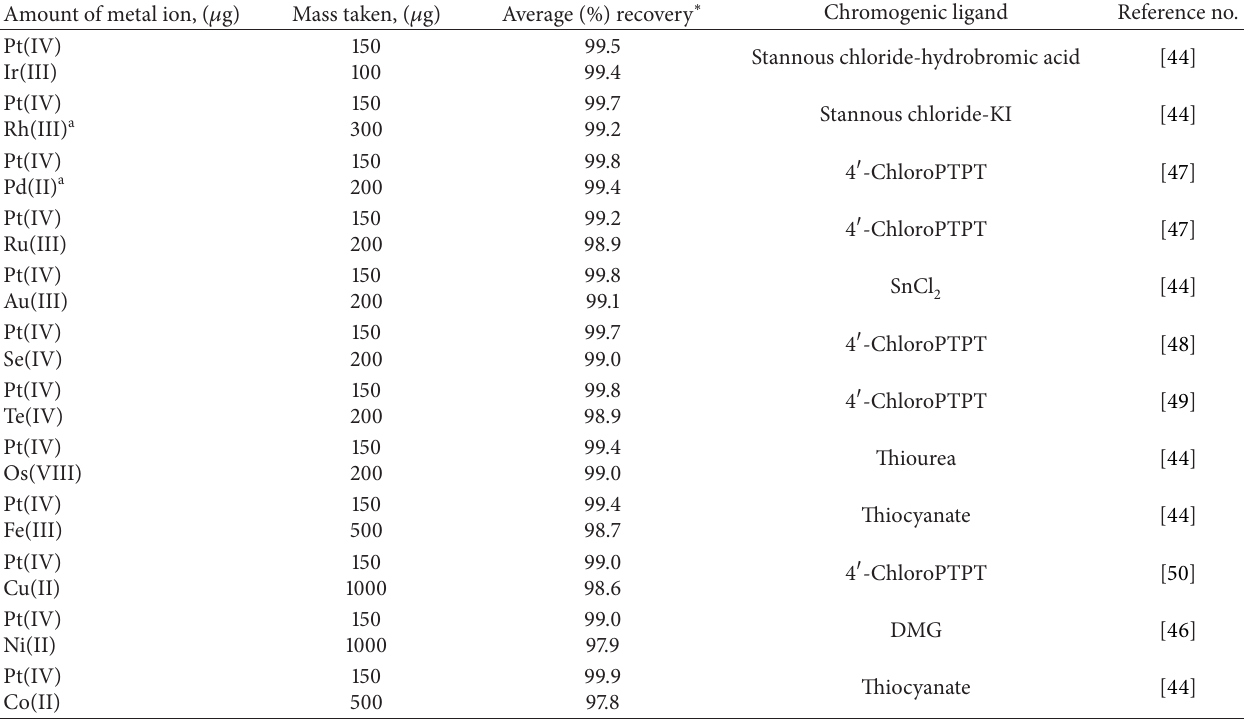
a Masked with 20mg tartrate. ∗ Average of five